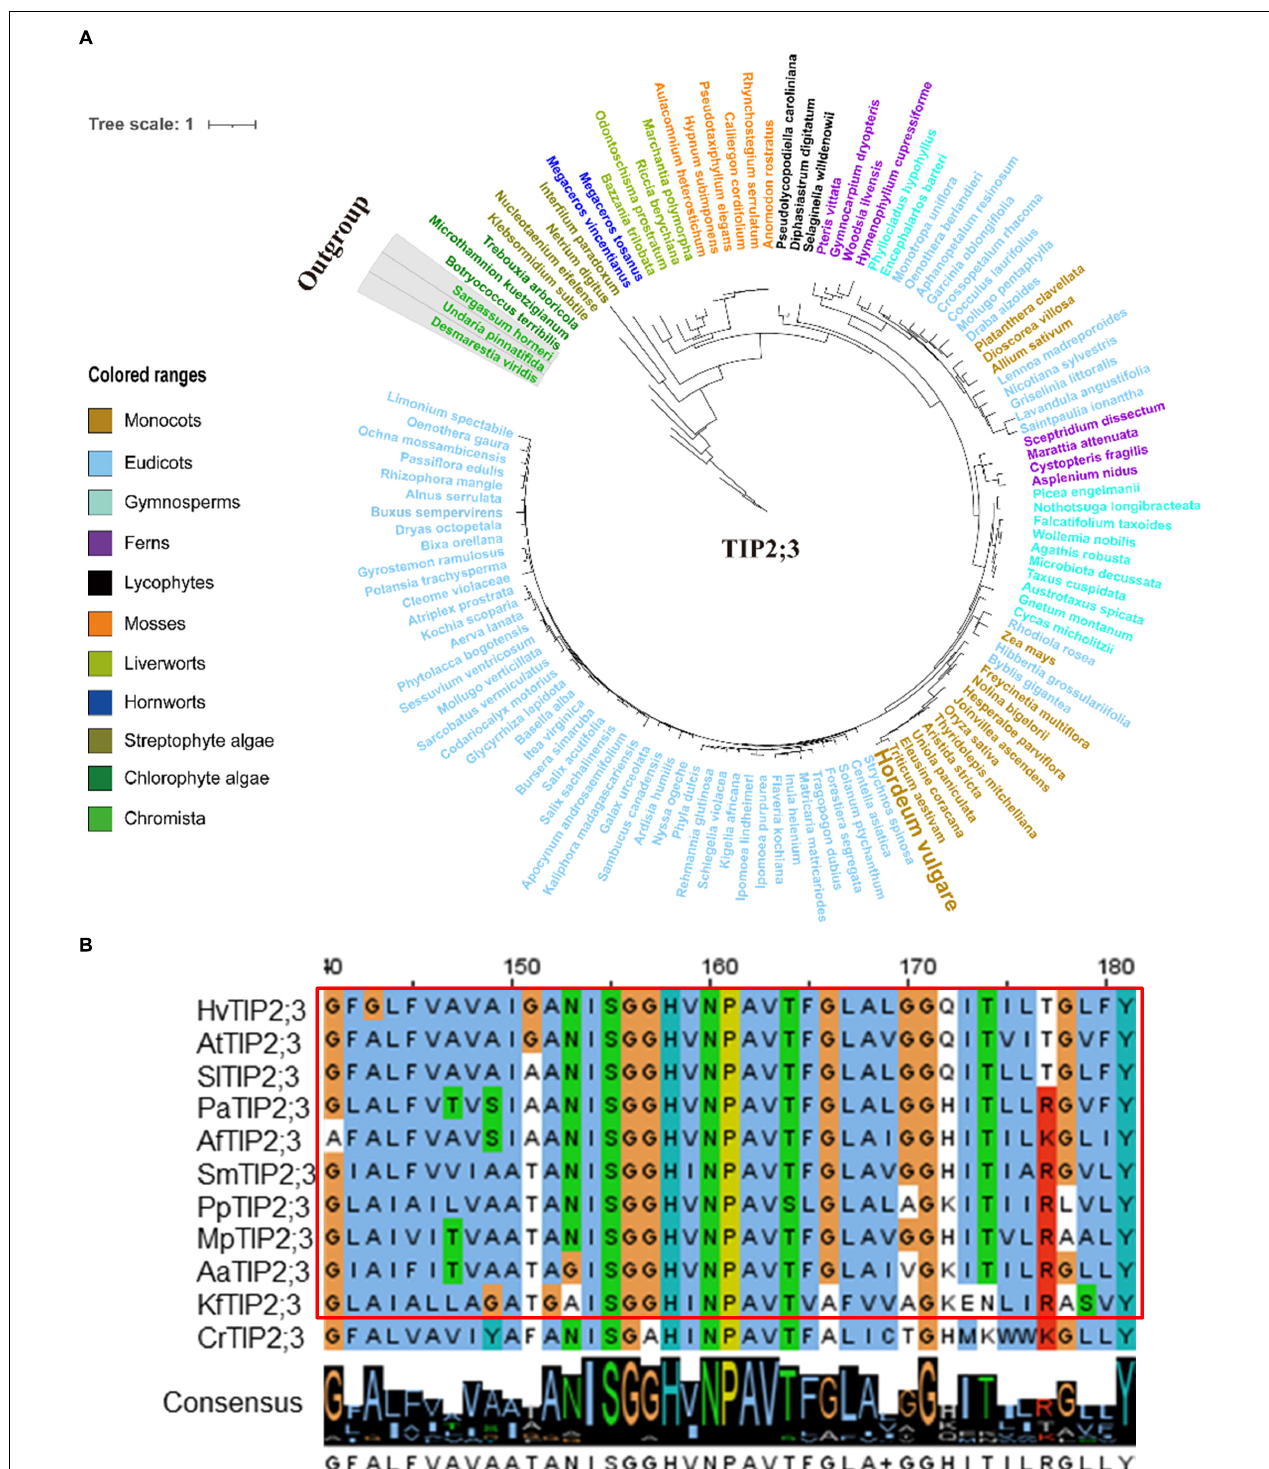
FIGURE 5 | Molecular evolutionary analysis of the aquaporins TIP2;3 in plants and algae. (A) The phylogenetic tree of TIP2;3 proteins in representative species of major lineage of plants and algae (See Supplementary Figure 9A for all OneKP species). The maximum likelihood (ML) method was used to construct the tree. Clades are indicated by different colors. (B) Conserved motif alignment of TIP2;3 in eleven representative plants and algal species. Hv, Hordeum vulgare; At, Arabidopsis thaliana; Sl, Solanum lycopersicum; Pa, Piceaabies; Af, Azolla filiculoides; Sm, Selaginella moellendorffii; Pp, physcomitrella patens; Mp, Marchantia polymorpha; Aa, Anthoceros angustus; Kf, Klebsormidium flaccidum; Cr, Chlamydomonas reinhardtii .